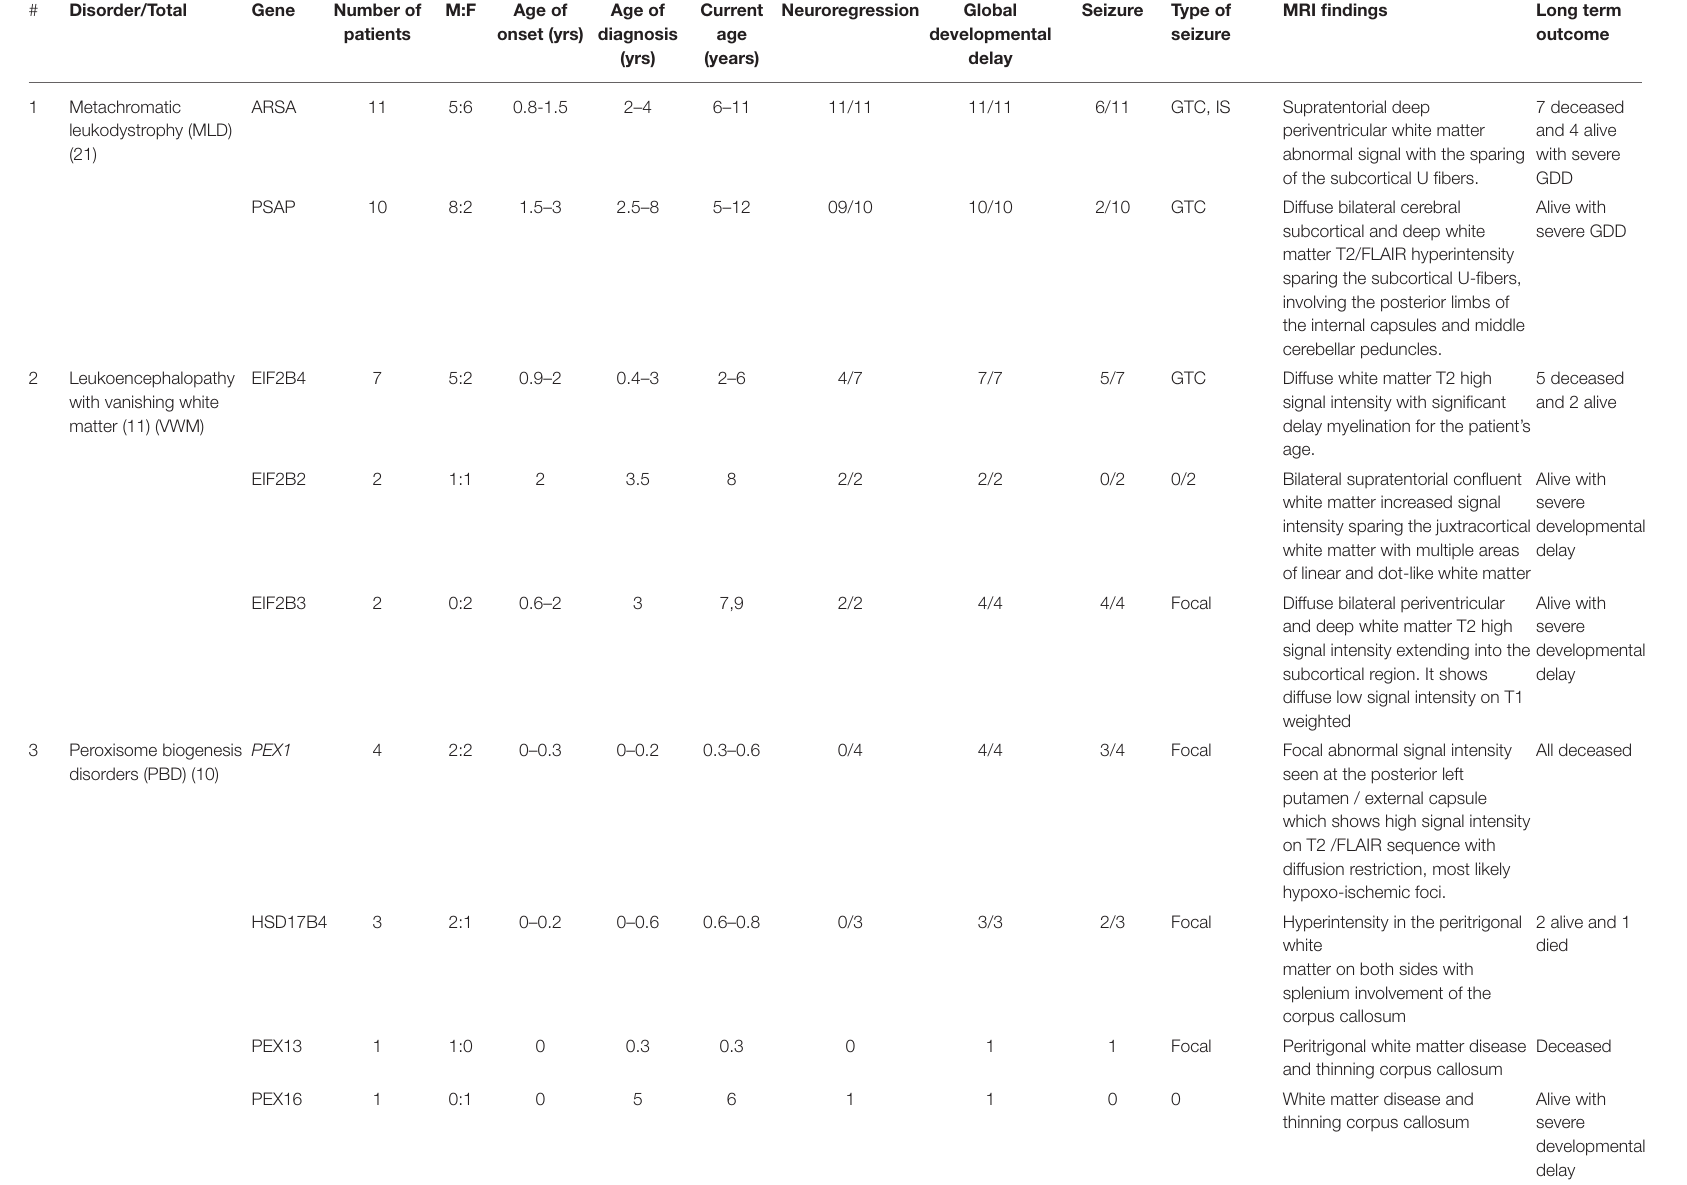
TABLE 2 | Summary of demographic and clinical